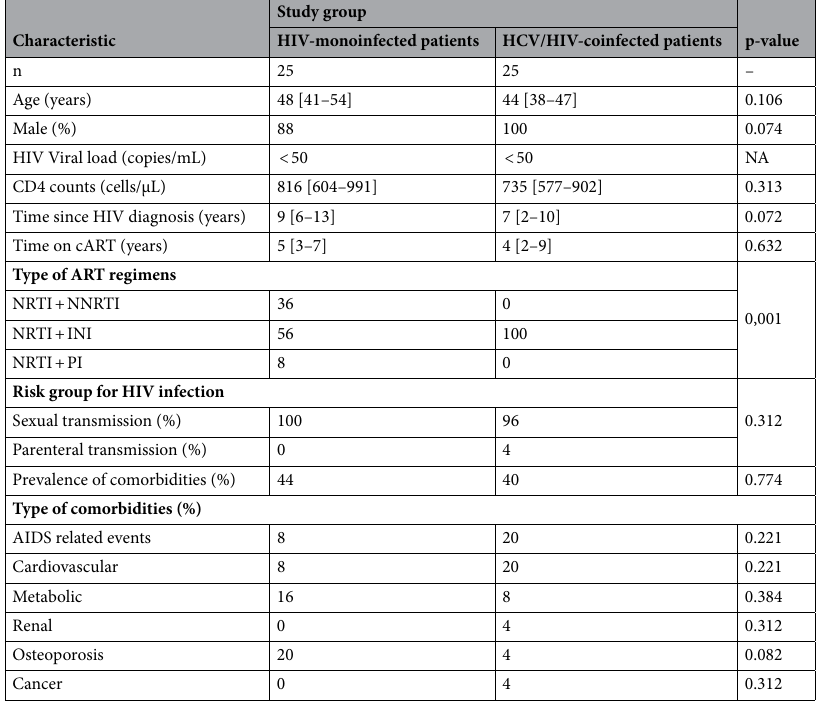
Table 1. Characteristics of patients at the time of inclusion in the study. Data are expressed as median [IQR], except sex and risk group for HIV infection, expressed as %; p-value: comparison between HIV-monoinfected and HCV/HIV-coinfected groups (U-Mann–Whitney test), except sex, type of ART regimens, risk group for HIV infection and comorbidities (evaluated with χ 2 test). NA not apply, NRTI nucleoside analog